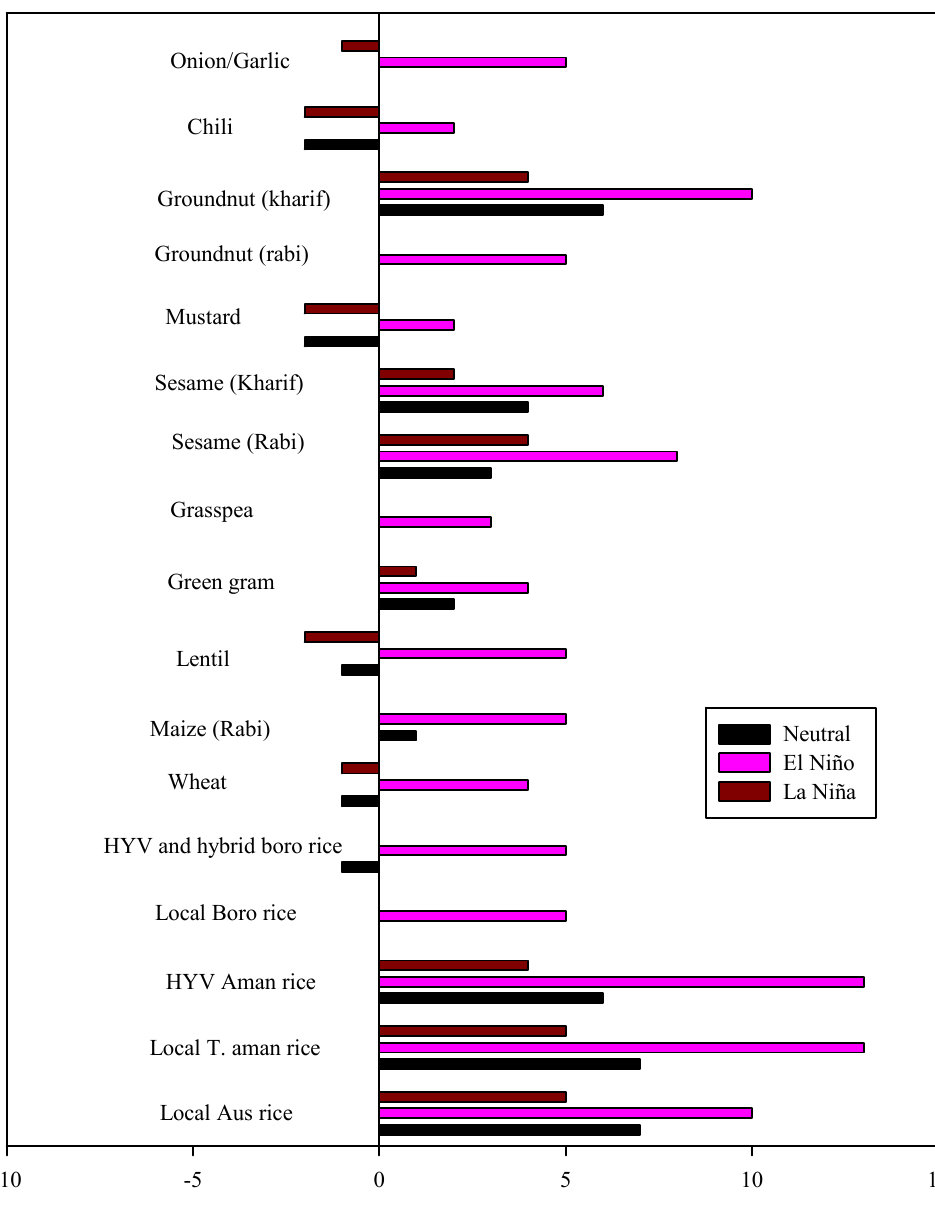
Figure 7. Estimated difference in growth duration of different crops grown between Barishal and Khulna regions.